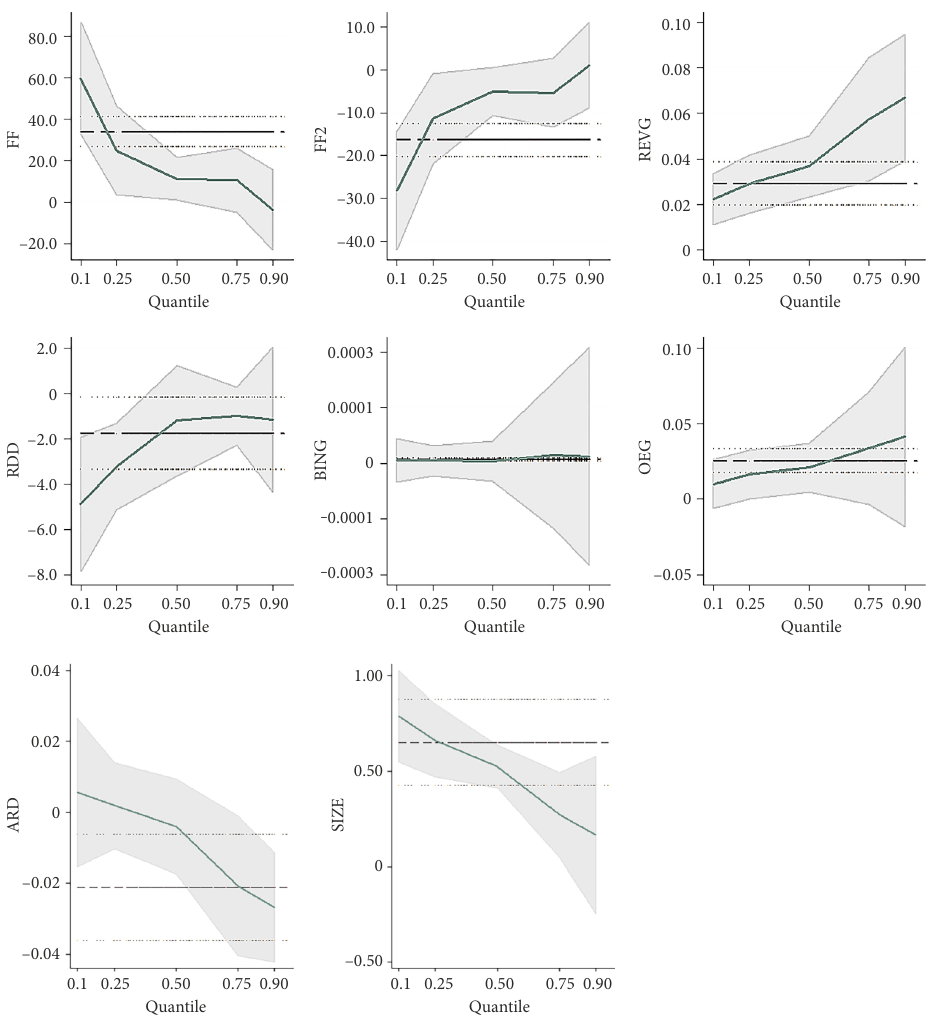
Figure 4. Graphical representation of OLS and QR estimates for the